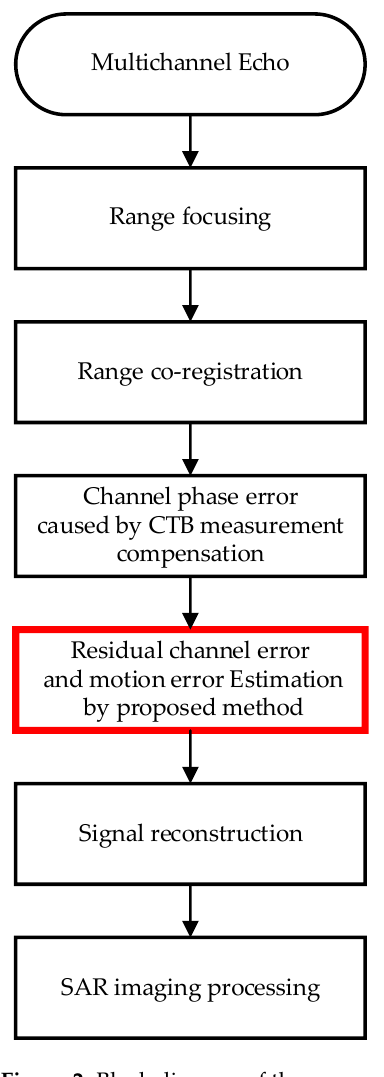
Figure 2. Block diagram of the processing flow. Firstly, range focusing is performed on the multi-channel echoes using range com- pression and then the range coregistration method proposed in [32] to eliminate envelope migration caused by the CTB and range sampling time delay. According to the measured value of the CTB, the slant range difference between channels can be obtained using Equa- tion (2), and the phase error corresponding to the measured value of the CTB in Equation (1) is compensated. After the above processing, Equation (1) becomes (